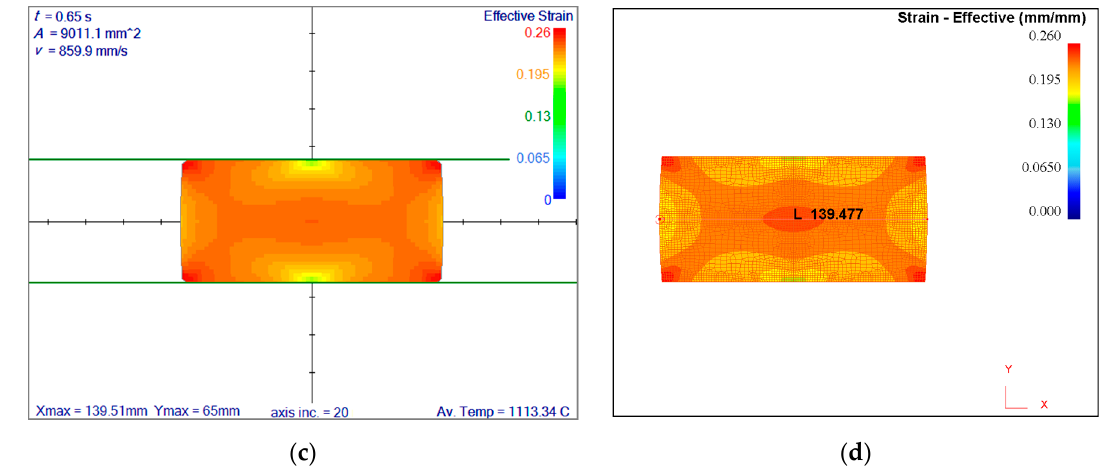
Figure 6. ( a ) Local Radial Basis Function Collocation Method (LRBFM) result vs. Finite Element Method (FEM) result when there is no heat flux at the boundaries, uniform temperature filed at the beginning. The increase in temperature is achieved by internal heat generation due to plastic deformation. Initial size: 126 × 81 mm, compressed to 65 mm height. ( b ) The comparison of final shapes after the deformation. Effective strain fields are calculated by LRBFCM ( c ) and FEM ( d ).